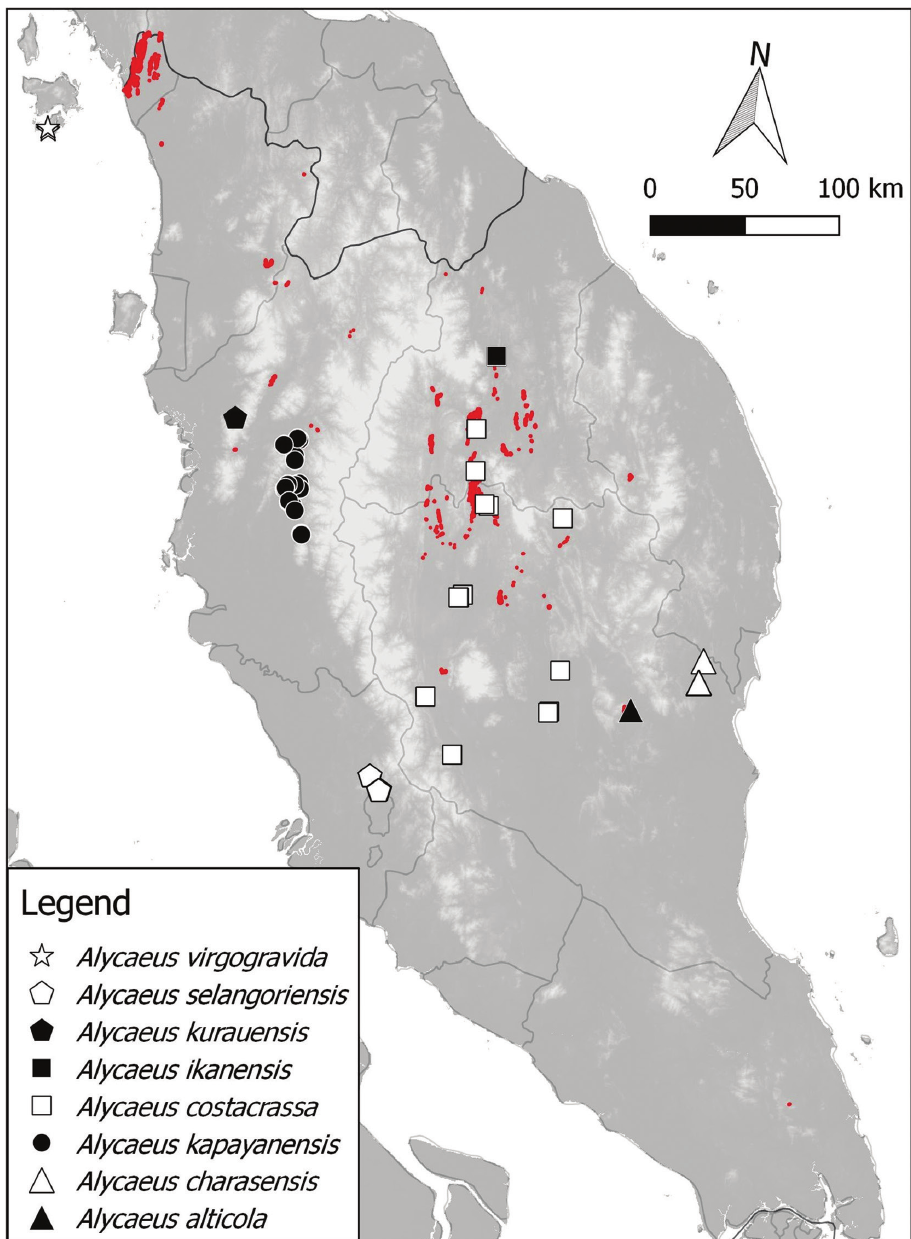
Figure 2. Distribution of 8 Alycaeus species in Peninsular Malaysia based on materials examined. Aly- caeus altispirus is not included in the maps because no specific locality was given for the materials exam- ined (see Discussion section under the species). Note the red areas are limestone karsts (derived from Liew et al.